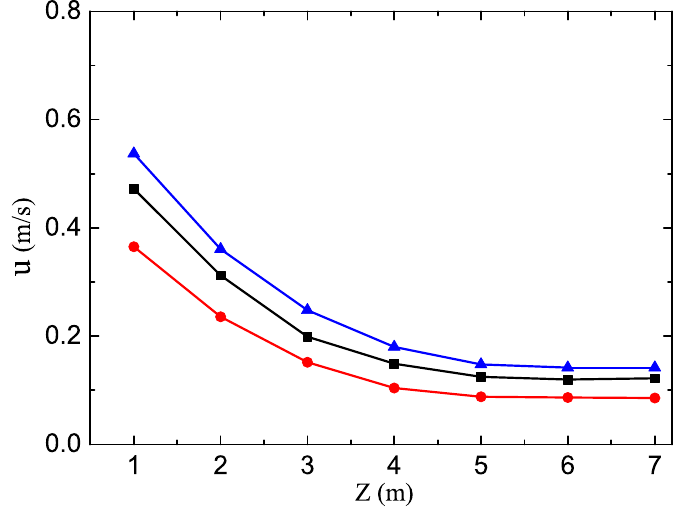
Figure 3. The speed of the flow versus the height Z for the different